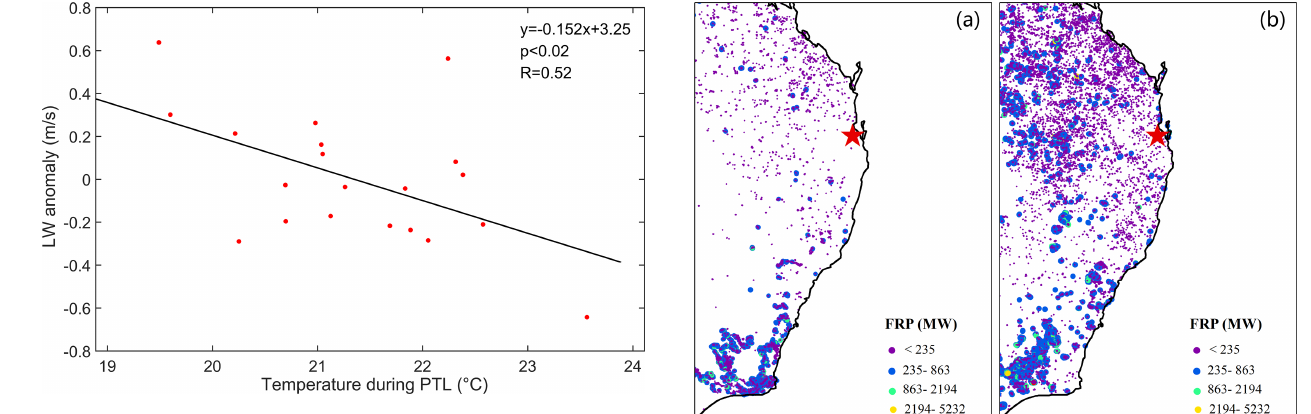
Figure 5. The relationship between LW anomaly and temperature during PTL based on their monthly average during January from 2001 to 2020.